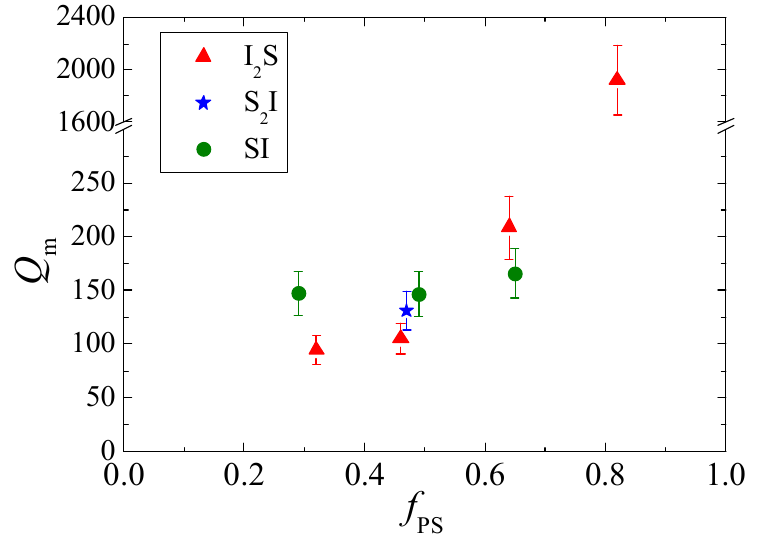
Figure 3. The aggregation number Q m of the micelles, calculated from the analysis of the forward scattering, for the 2 wt% blends of the I 2 S graft (solid triangles), the S 2 I graft (star), and the linear copolymers (solid circles) within the polyisoprene matrix at room temperature, as a function of the polystyrene volume fraction of the copolymer.